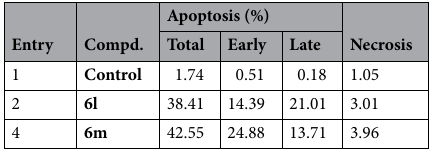
Table 3. % Apoptosis and necrosis of compounds 6l , 6m and control experiment for MCF7 (breast cancer cell line).